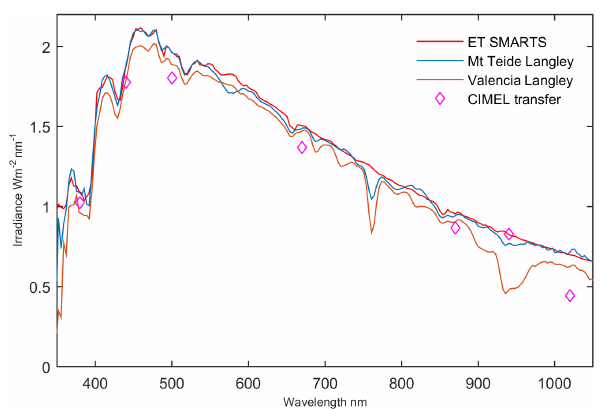
Figure 4. Calibration curve for Spectrometer 2 (Zeiss). Extra- terrestrial spectrum as predicted from the SMARTS2 model, Lang- ley calibrations on Mt Teide (Tenerife), Valencia (Spain) and from calibration transfer from the CIMEL sun photometer at